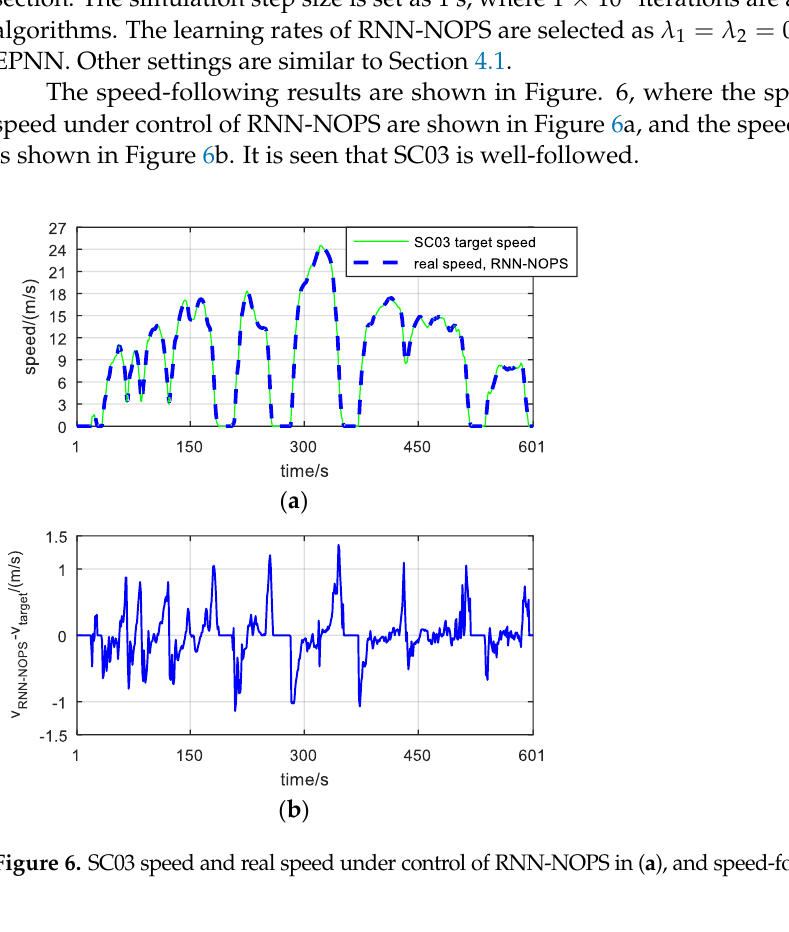
Figure 5. Braking performance of RNN-NOPS and EPNN in terms of adhesion utilization in ( a , b ), respectively; torque allocation in ( c , d ), respectively; power allocation in ( e , f ), respectively.